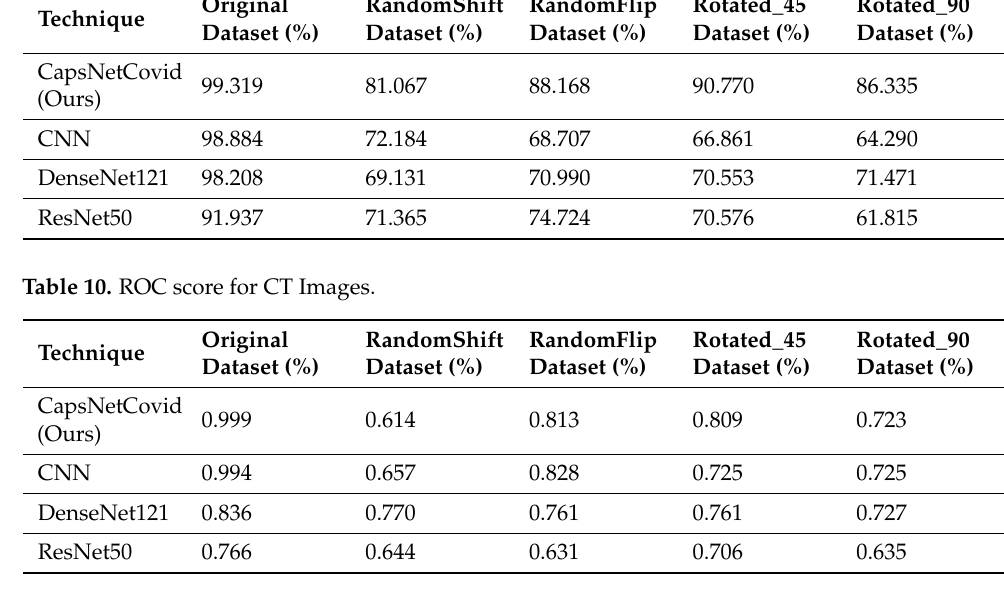
Table 9. F1-Score of CapsNetCovid, CNN, DenseNet121, and ResNet50. Technique